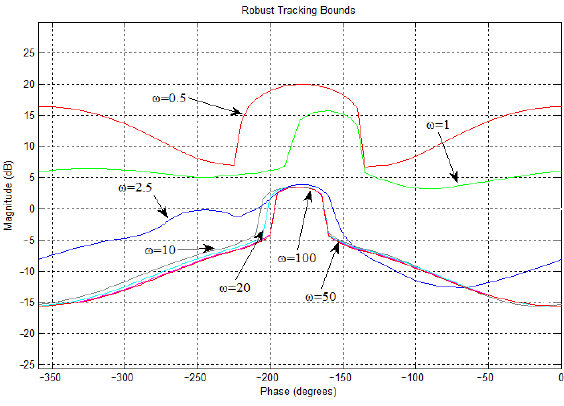
Figure 13. Loop-shaping in Nichols chart for the vertical plane